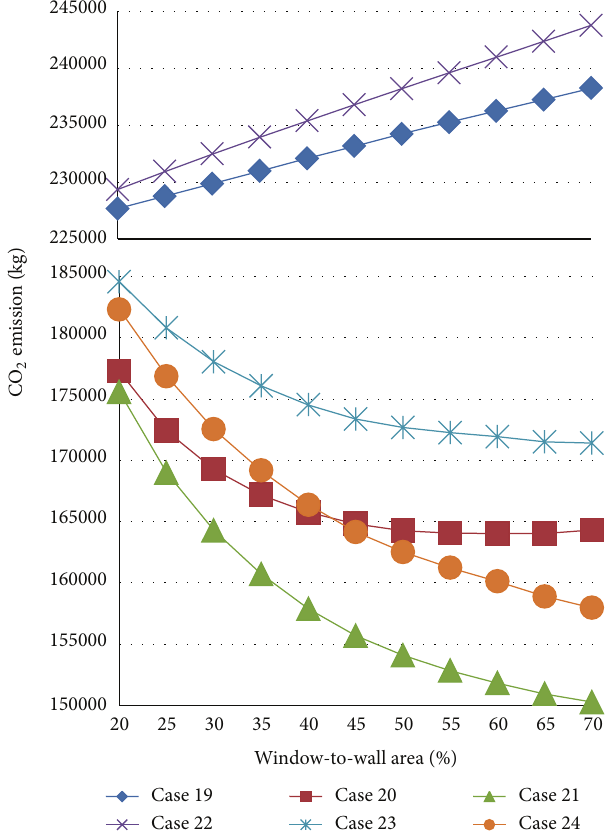
Figure 10: Results for cases 19–24.